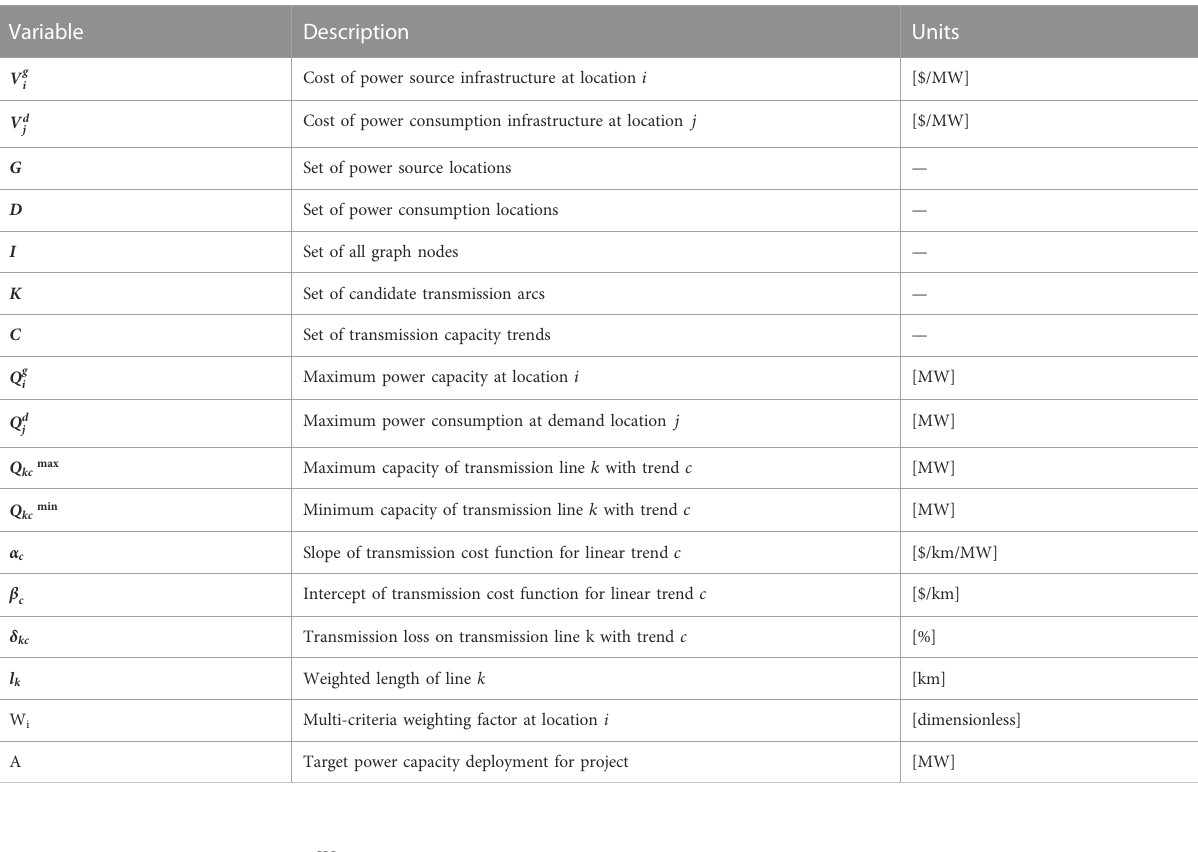
TABLE 2 Input data for SimWIND PRO . Variable